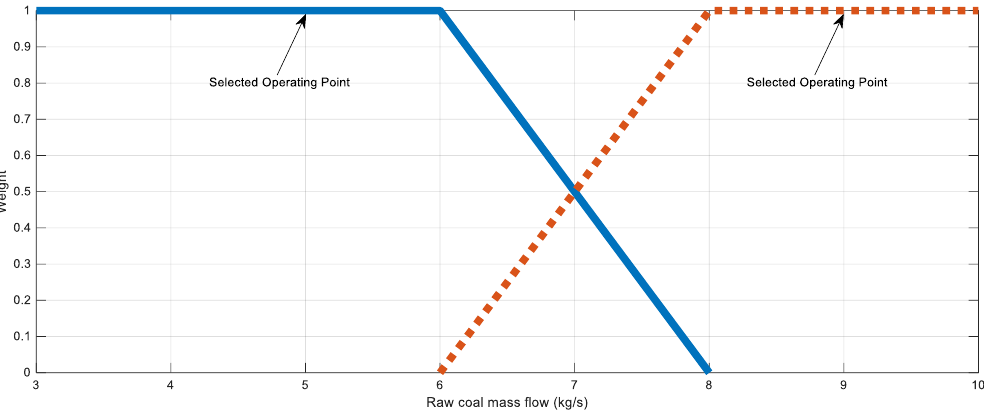
Figure 7. Weighting functions and scheduling variable: ϕ 1 = solid line, ϕ 2 = dotted line.